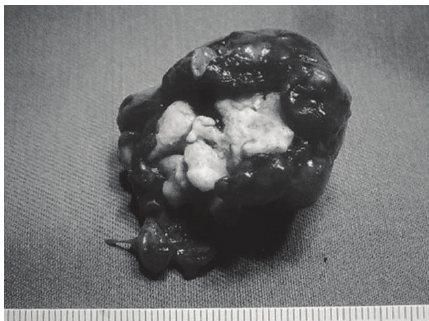
Figure 3: Tumor size and diameter. The tumor was round and 4cm in diameter. An irregular osseous mass covered with mucosa was observed.